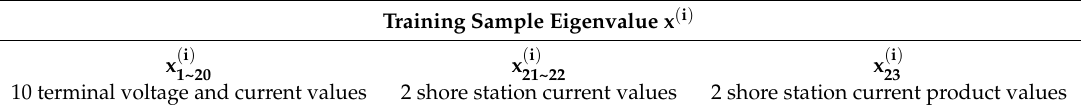
Table 1. Training sample